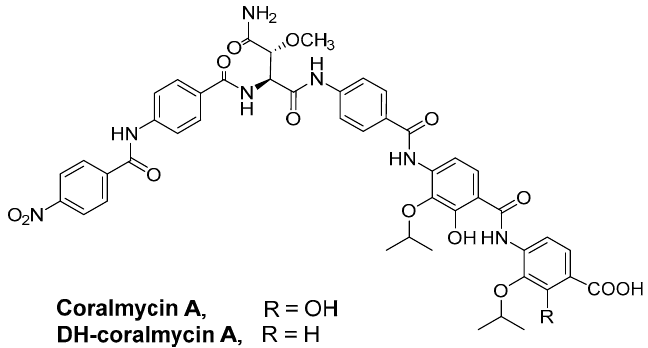
Figure 1. Chemical structures of coralmycins.